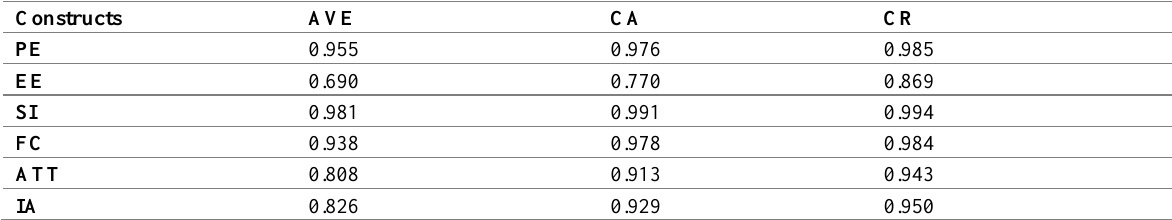
Table 3: Validity and Reliability Analysis